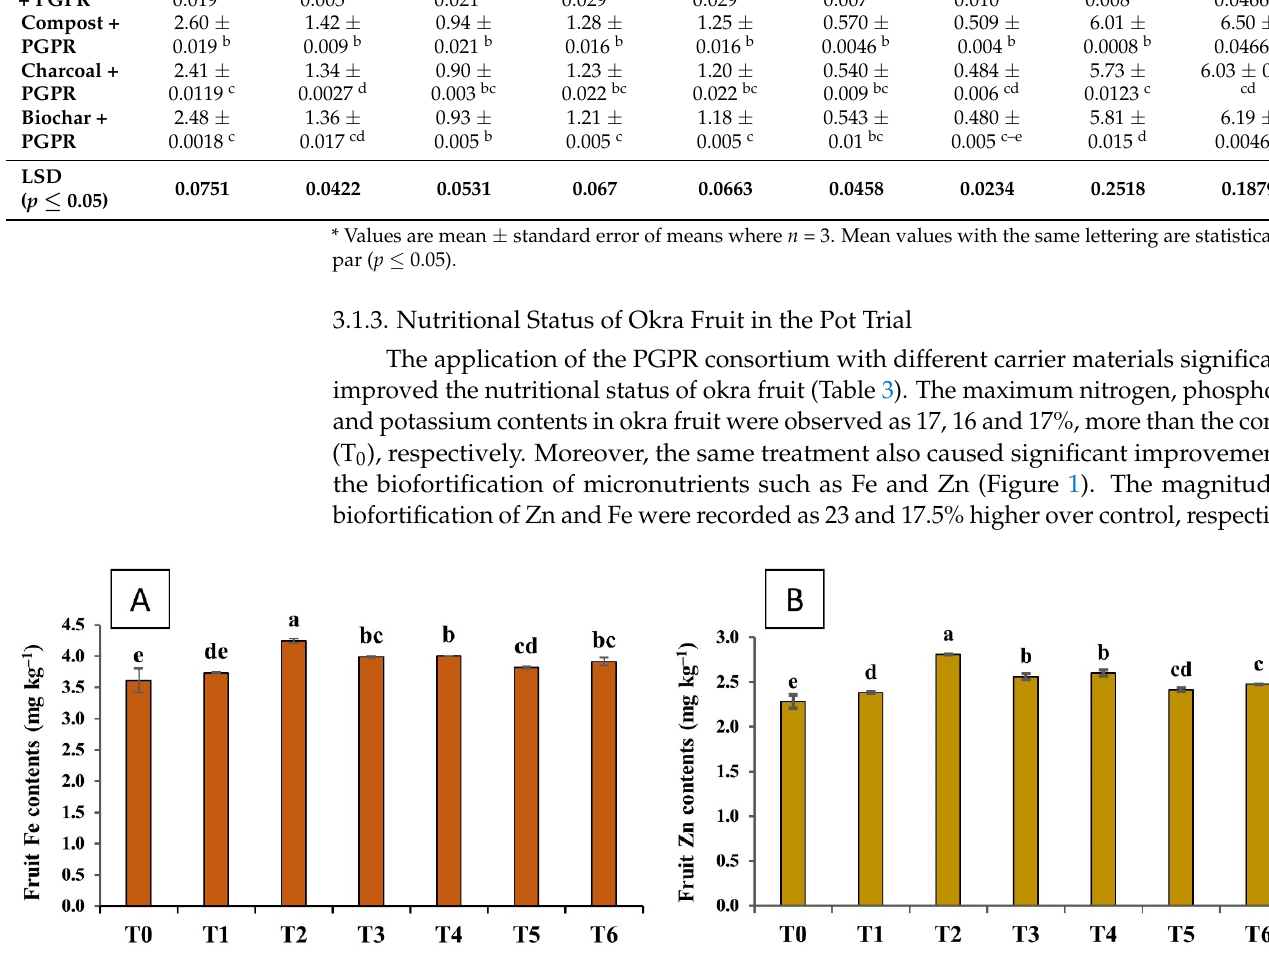
Figure 1. Effect of different carrier materials on the iron ( A ) and zinc ( B ) concentration in okra fruit under pot trial. The bars represent the mean values with error bars representing the standard error of means where n = 3. The bars with different letters are statistically different from each other at p ≤ 0.05 according to the least significant difference (LSD)